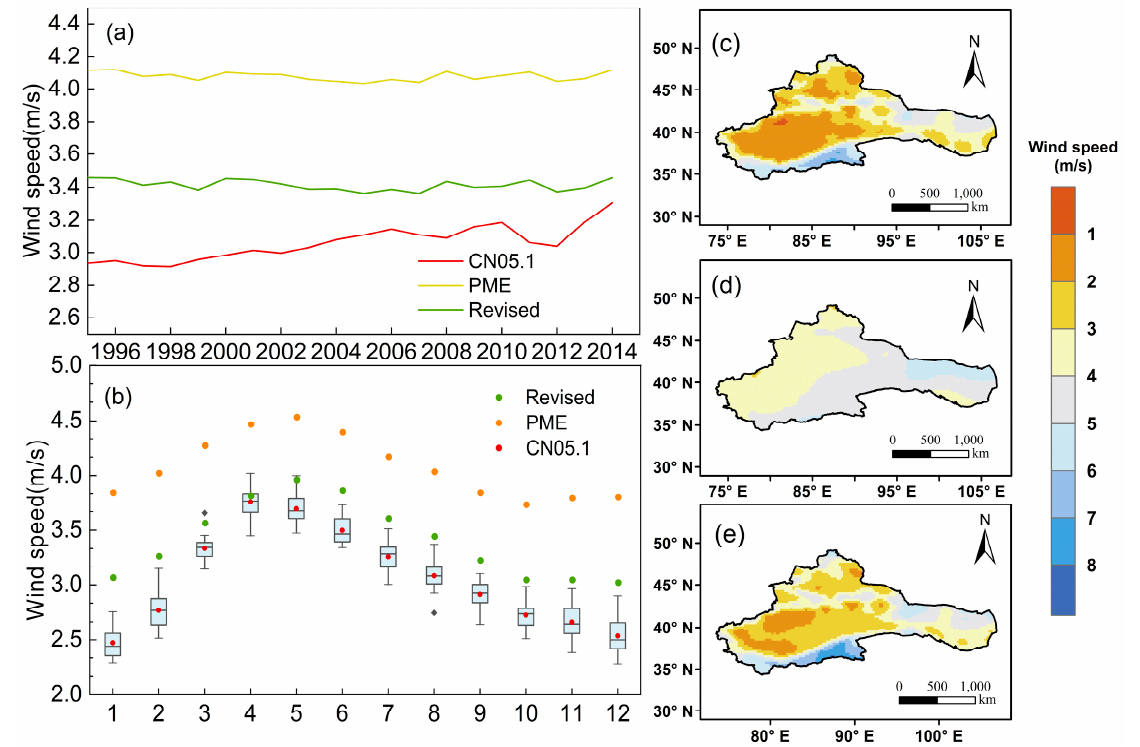
Figure 3. Comparison between revised/unrevised PME and observation in time and space. ( a ) annual mean surface wind speed ( b ) monthly mean surface wind speed ( c ) observed wind speed ( d ) simulated wind speed by the unrevised PME ( e ) simulated wind speed by the revised